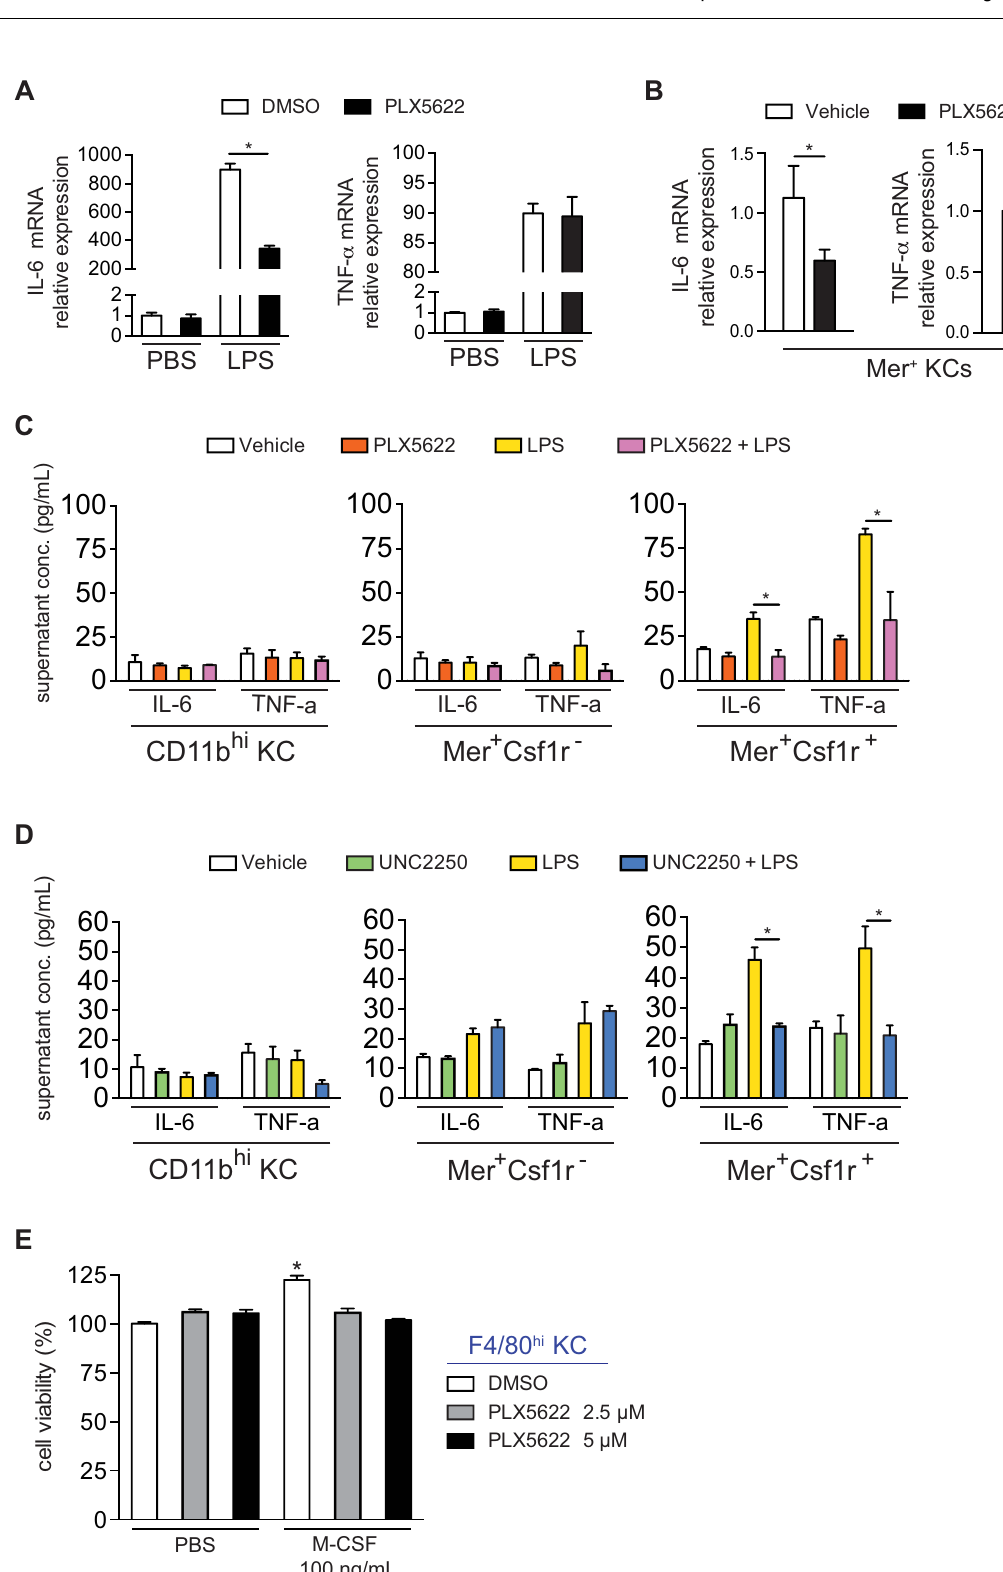
Fig 4. Csf1r or Mer inhibition diminishes KC cytokine production in vitro. (A) IL-6 (left) and TNF- α (right) as measured by quantitative PCR in freshly isolated F4/80 hi KCs cultured overnight with PLX5622 and then treated with LPS for 4h. (B) IL-6 (left)